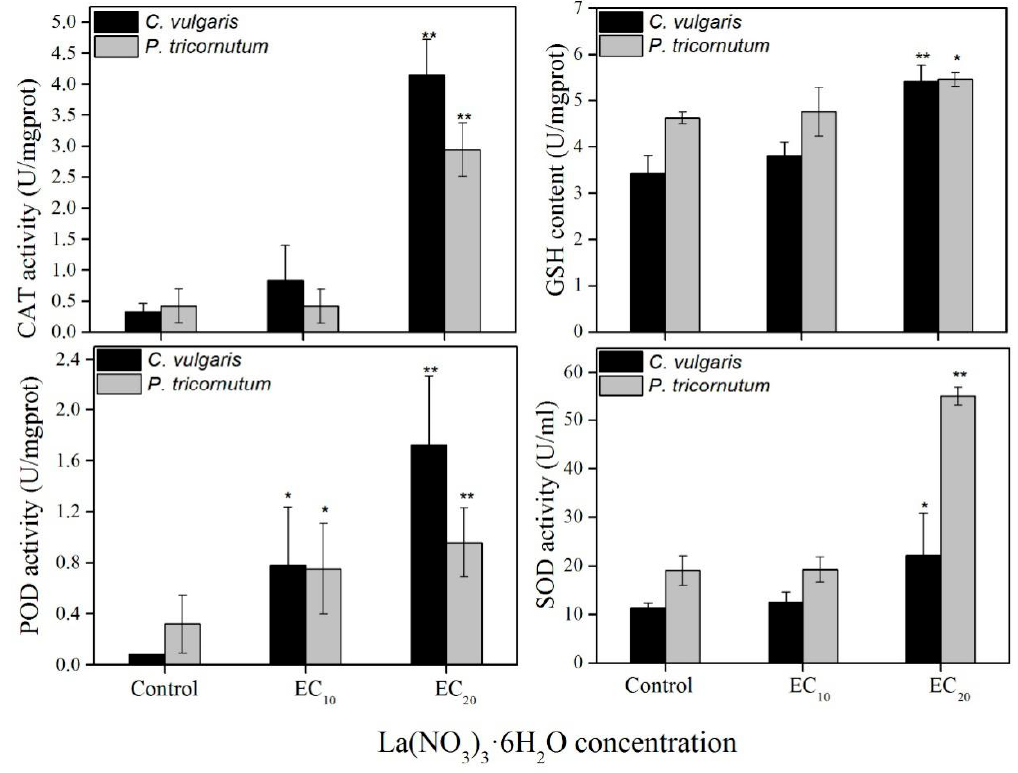
Figure 5. The effect of La(NO 3 ) 3 ·6H 2 O on antioxidant enzyme (catalase (CAT) , peroxidase (POD) and superoxide dismutase (SOD)) activities and glutathione (GSH) content of C. vulgaris and P. tricornutum after 96 h. * Significant di ff erence compared with the control ( p < 0.05). ** Significant di ff after 96 h. * Significant difference compared with the control ( p < 0.05). ** Significant difference compared with the control ( p < 0.01).